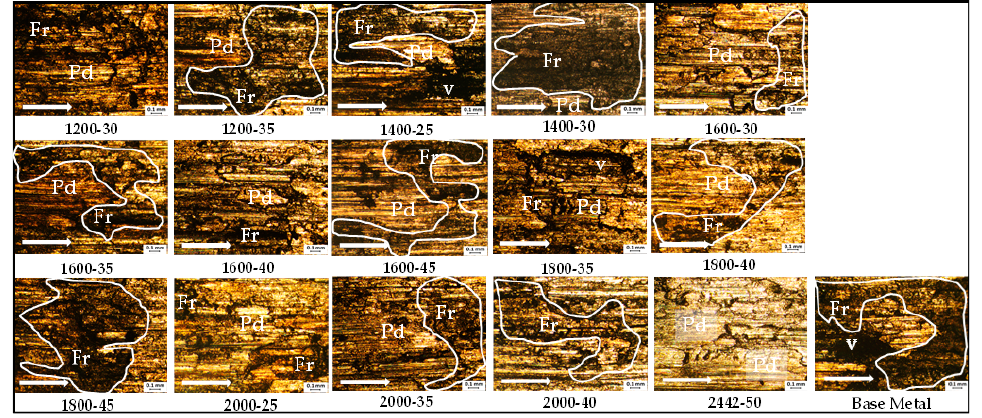
Figure 20. Wear morphology of substrate material and FSPed recycled AA 6063/TiO 2 produced by different processing parameters after 2.5 km of sliding distance test subject to a nominal contact pressure of 0.24 MPa at a sliding speed of 2.88 m/s under starved lubrication conditions. (Note: white arrow indicates sliding direction, V: voids, Fr: fractures, Pd: plastic deformation).